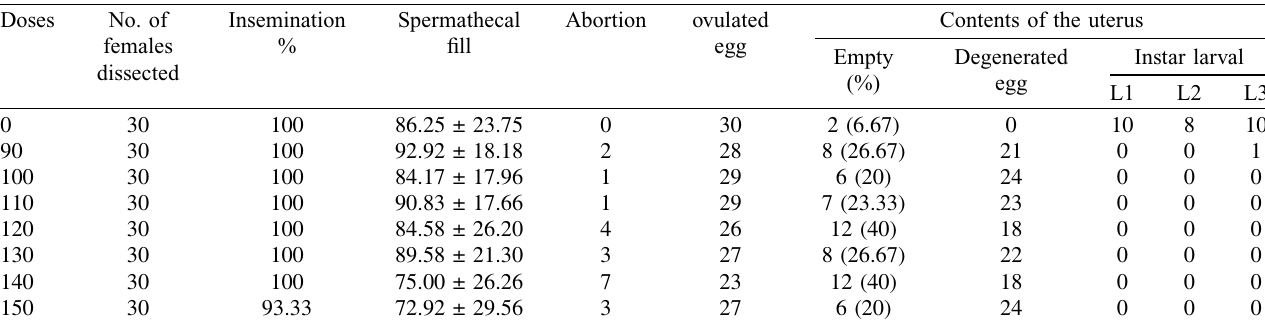
Table 2. Dissection results of G. palpalis gambiensis females mated with males irradiated with different doses. Doses No. of